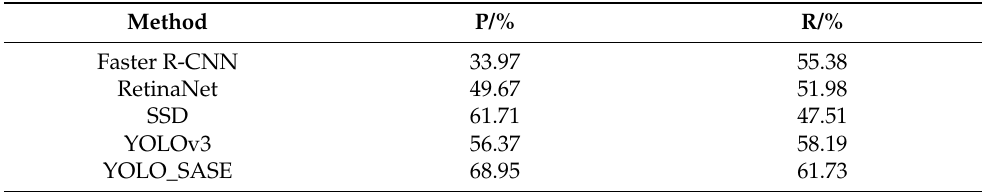
Table 7. Method results in Low SCR